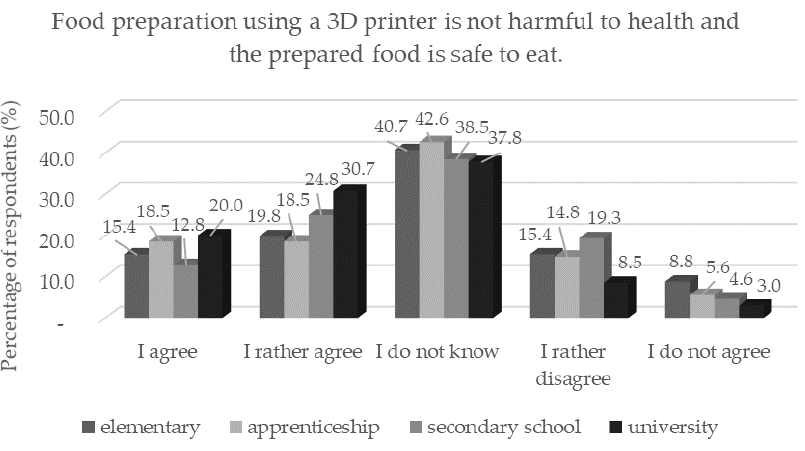
Figure 6. Respondents' worries and understandings ( n = 1156) by education in response to the